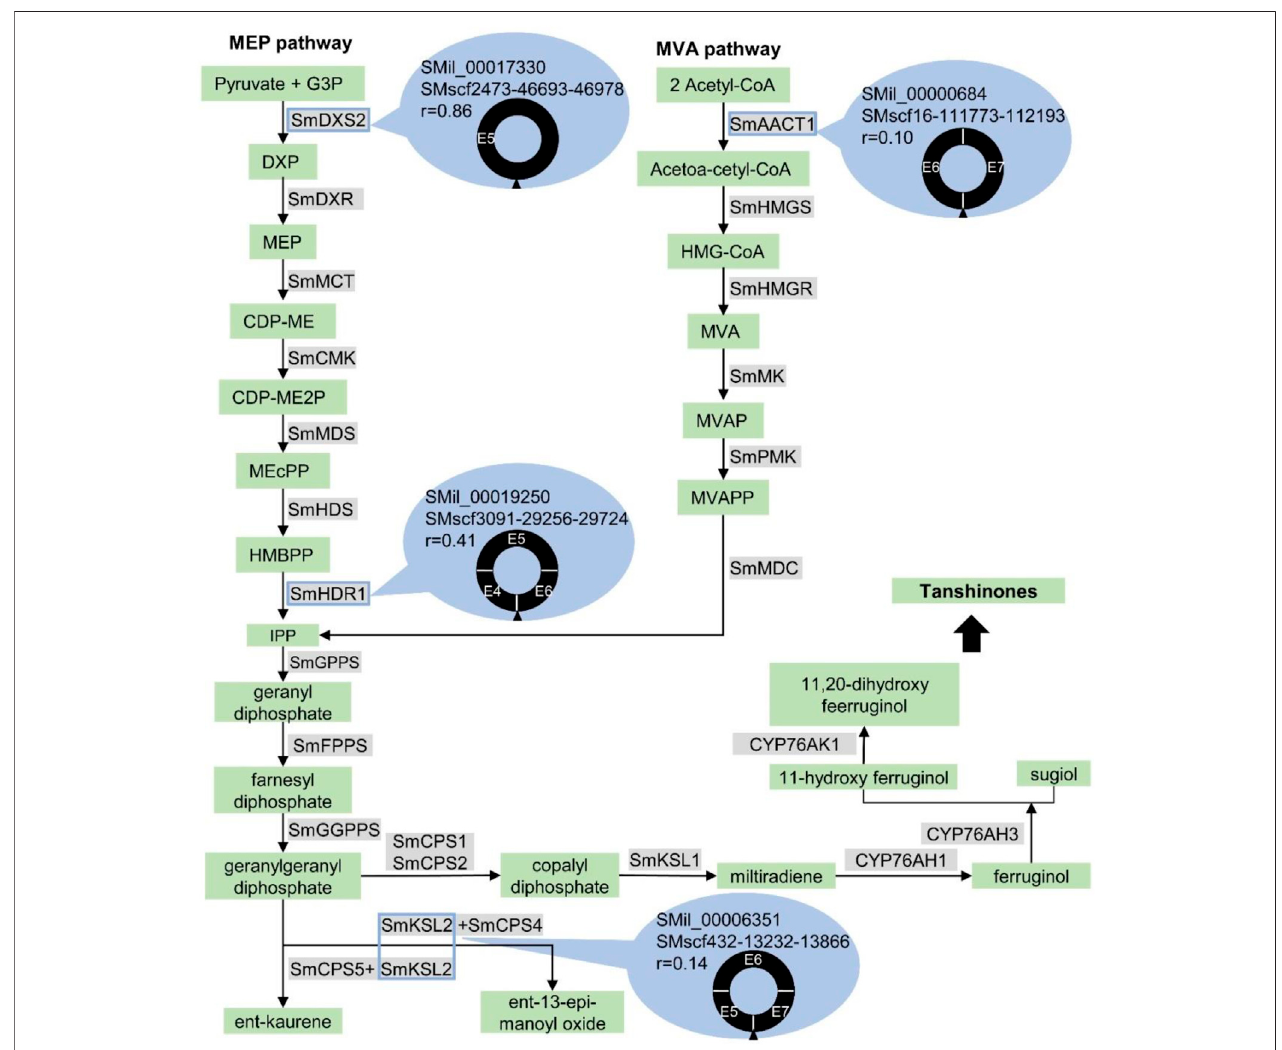
FIGURE 8 | Potential involvement of circRNAs in the tanshinone biosynthesis in S. miltiorrhiza . The enzymes and chemical compounds were shaded in gray and green, respectively. Solid arrows indicated the reactions that are experimentally validated. Dashed arrows indicated the hypothetical reactions. The genes that produce circRNAs,SmAACT1,SmDXS2,SmHDR1,andSmKSL2,aremarkedbybluerectangles.ThegeneID,circRNAID,theexpressedcorrelationbetweengeneandcircRNA, and the structure of circRNAs were shown in blue ovals. The exons are labeled with “ E ” followed by the exon number. The black triangle indicates the junction